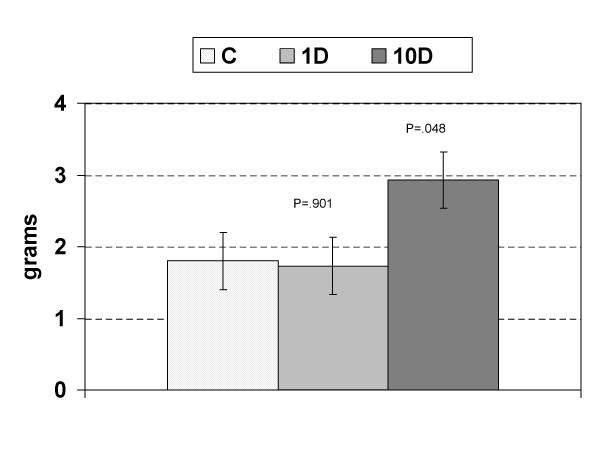
Body weight gain measurements verify an anabolicresponse. Body weight gain of mice following ten days of injections, including 24 hours (24 h) or 10 (10 D) days of clenbuterol administration, or a vehicle control (C). The overall effect of treatment on body weight gain showed a trend for significance (P = 0.06), and significance values from contrasts comparing each clenbuterol treatment to the control group are shown.